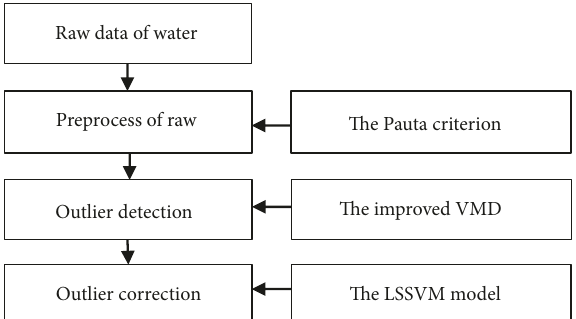
Figure 3: The block diagram of water quality outlier detection and correction